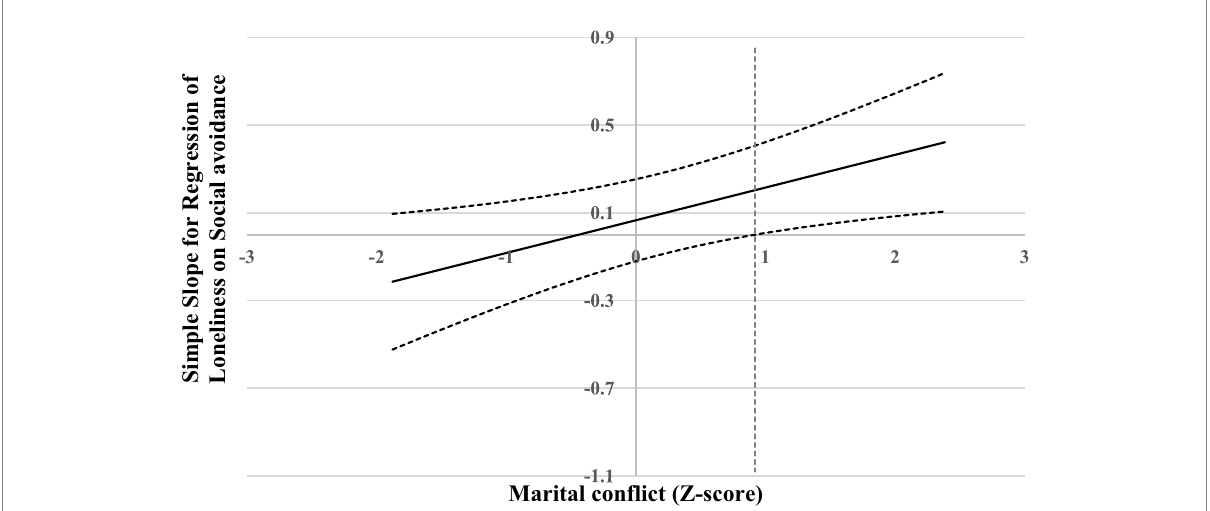
FIGURE 2 Johnson-Neyman regions of significance and confidence bands for social avoidance along marital conflict in relation to loneliness. Solid diagonal line represents the regression coefficient for social avoidance along marital conflict. Dashed diagonal lines are confidence bands—upper and lower bounds of 95% confidence interval for social avoidance coefficient along marital conflict. The dashed vertical red line indicates the point along marital conflict at which the social avoidance regression coefficient transitions from non-significance (left of dashed vertical line) to statistical significance (right of dashed vertical line). The value of the dashed vertical line is